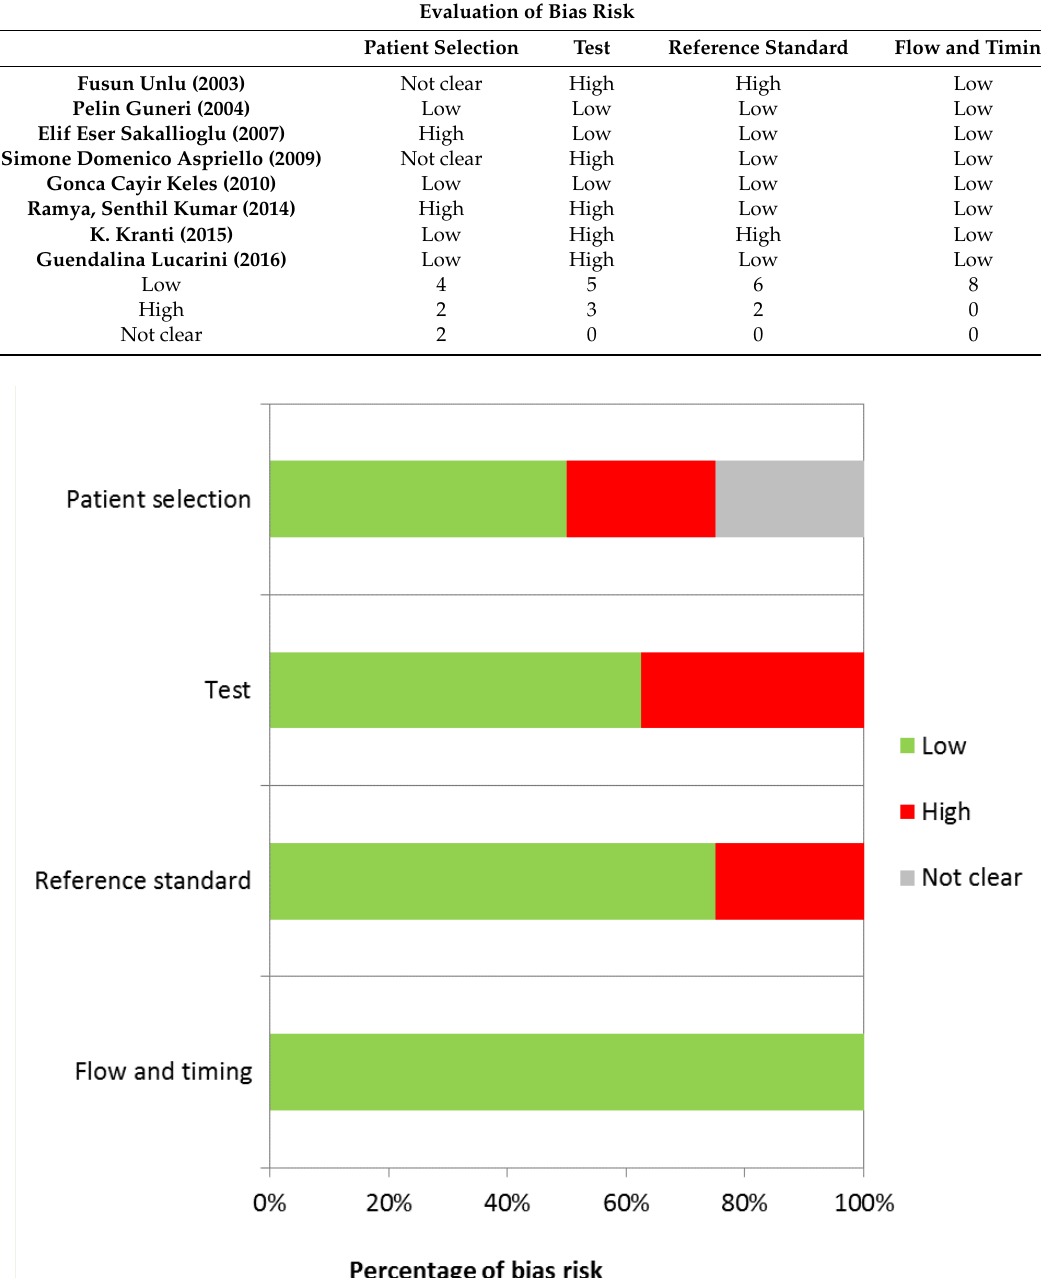
Table 3. Evaluation of bias